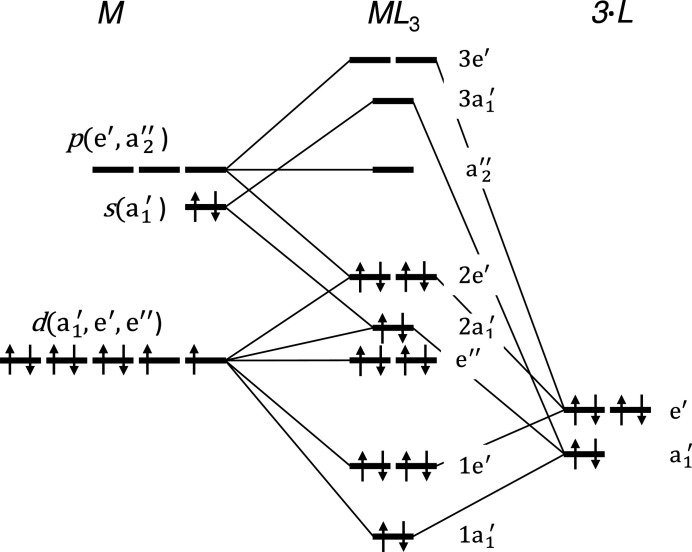
Distribution of the electrons in the ML
3 complex with respect to the molecular orbital theory (MO theory) following Jean et al. (1993 ▸). Electronic contribution of the metal M on the left, contribution of the ligands L on the right, molecular orbitals in the middle.